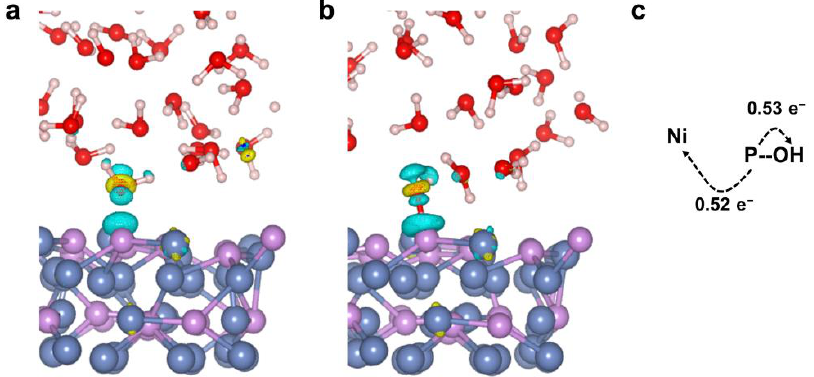
Figure 6. Electron density difference graphs: ( a ) P*OH 2 and ( b ) P*OH. The accumulation of electron density is indicated by the yellow color, while the depletion of electron density is indicated by the blue color. ( c ) Direction of electron transfer. The white, red, purple, and blue spheres represent H, O, P, and Ni, respectively. Table 3. Bader Charge Analysis of *+H 2 O, *OH 2 and *OH + H. H 2 O